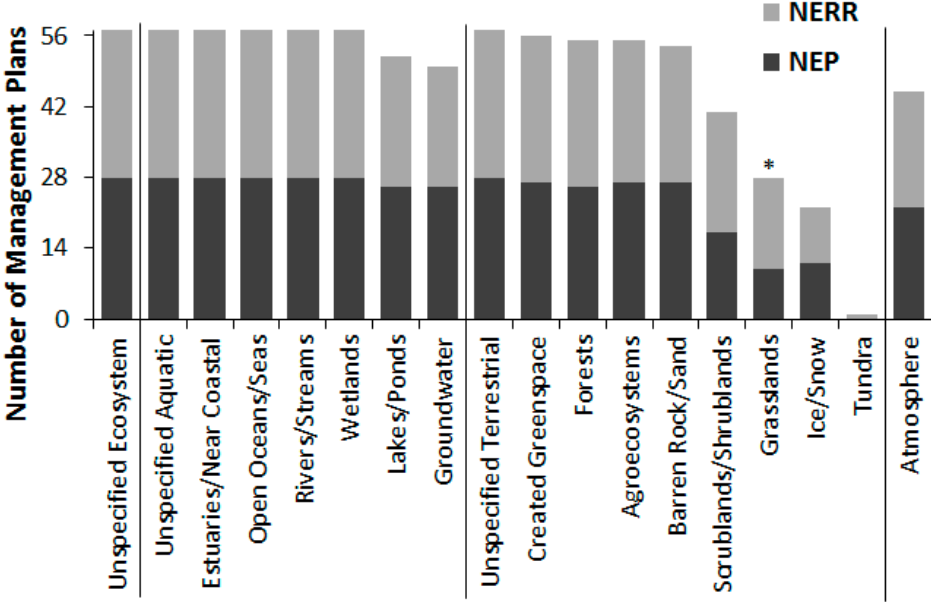
Figure 4. Number of NEP or NERR management plans mentioning each category of environment. Asterisks denote categories for which counts differed significantly (logistic regression; p < 0.05) between NEP and NERR.